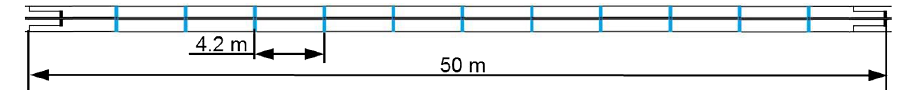
FIG. 6. Schematic diagram of a 50 m straight section of a cryogenic distribution line with Invar ® process